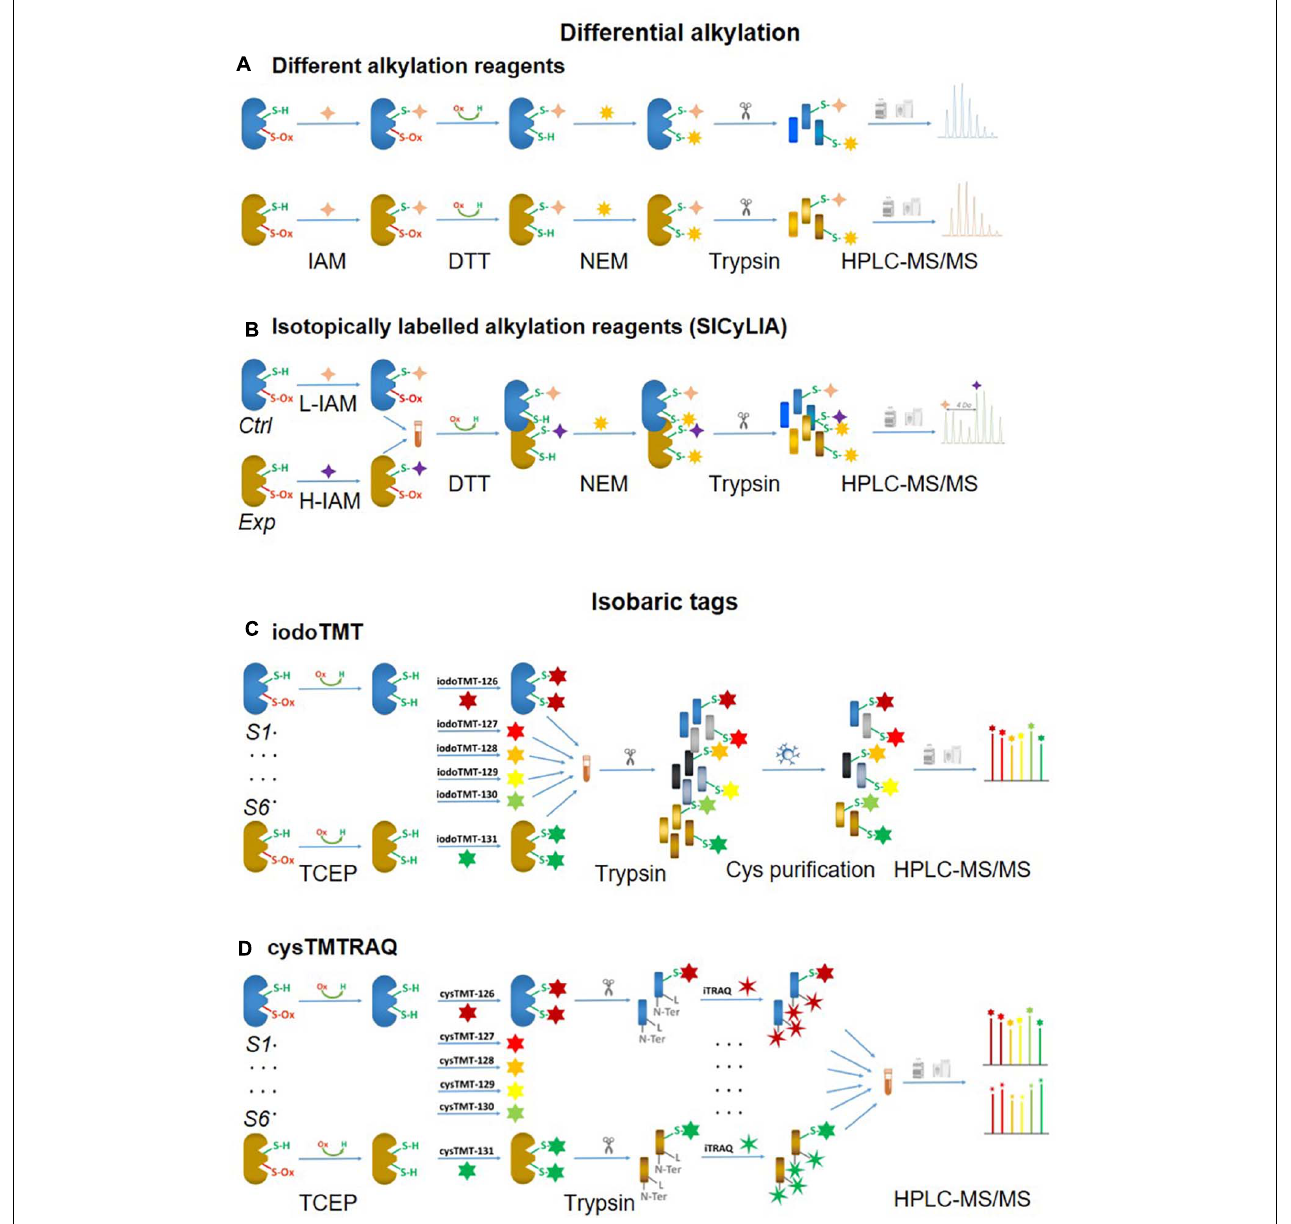
FIGURE 3 | Non-click chemistry-based thiol-reactive workflows. Different alkylation methods: (A) two chemically distinct alkylation reagents and (B) SICyLIA; isobariac tags: (C) iodoTMT and (D) cysTMTTRAQ.